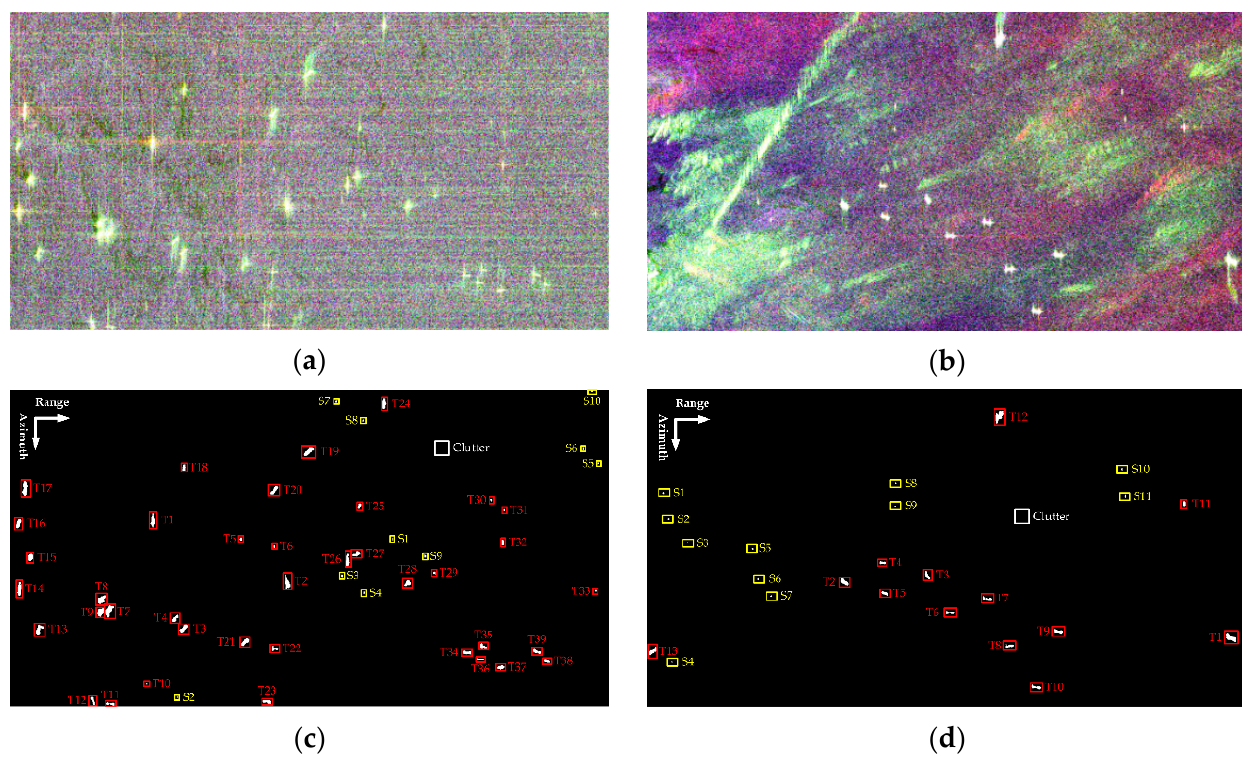
Figure 2. Pauli color-coding PolSAR data and their corresponding ground truths for different study sites. ( a , c ) GF3 data. ( b , d ) AIRSAR data. The strong and weak targets are marked by red and yellow rectangles, respectively.